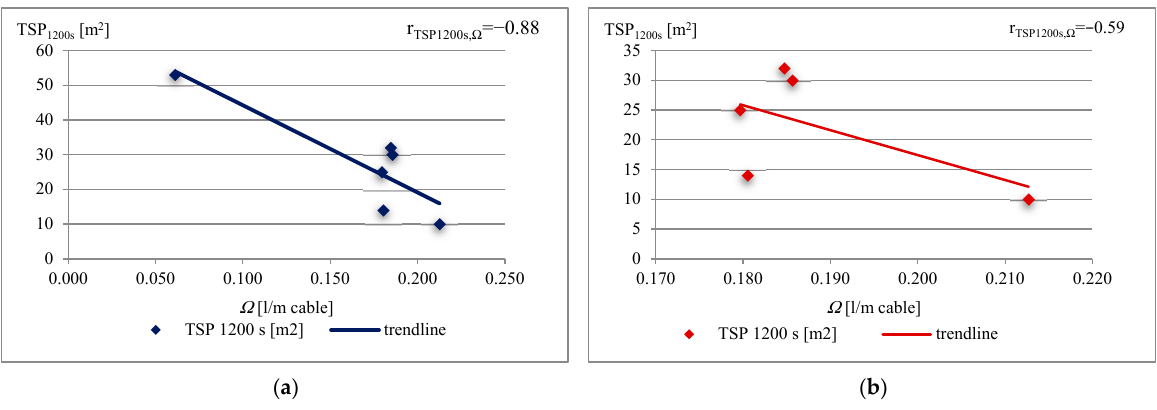
Figure 5. Correlation between TSP 1200s and Ω for the tested cables.